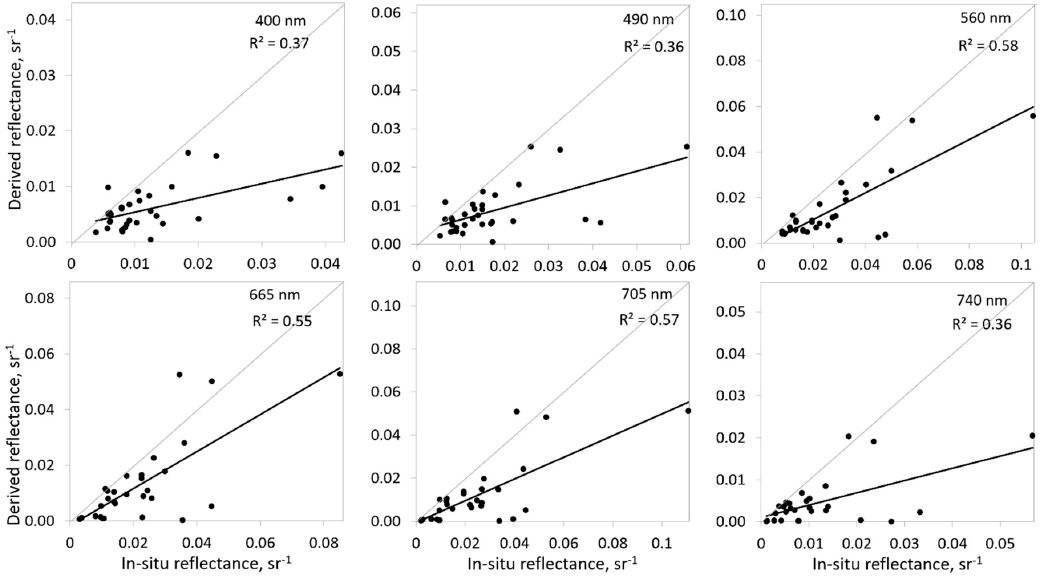
Figure B1. The comparison of the in-situ and MSI C2RCC spectral bands.